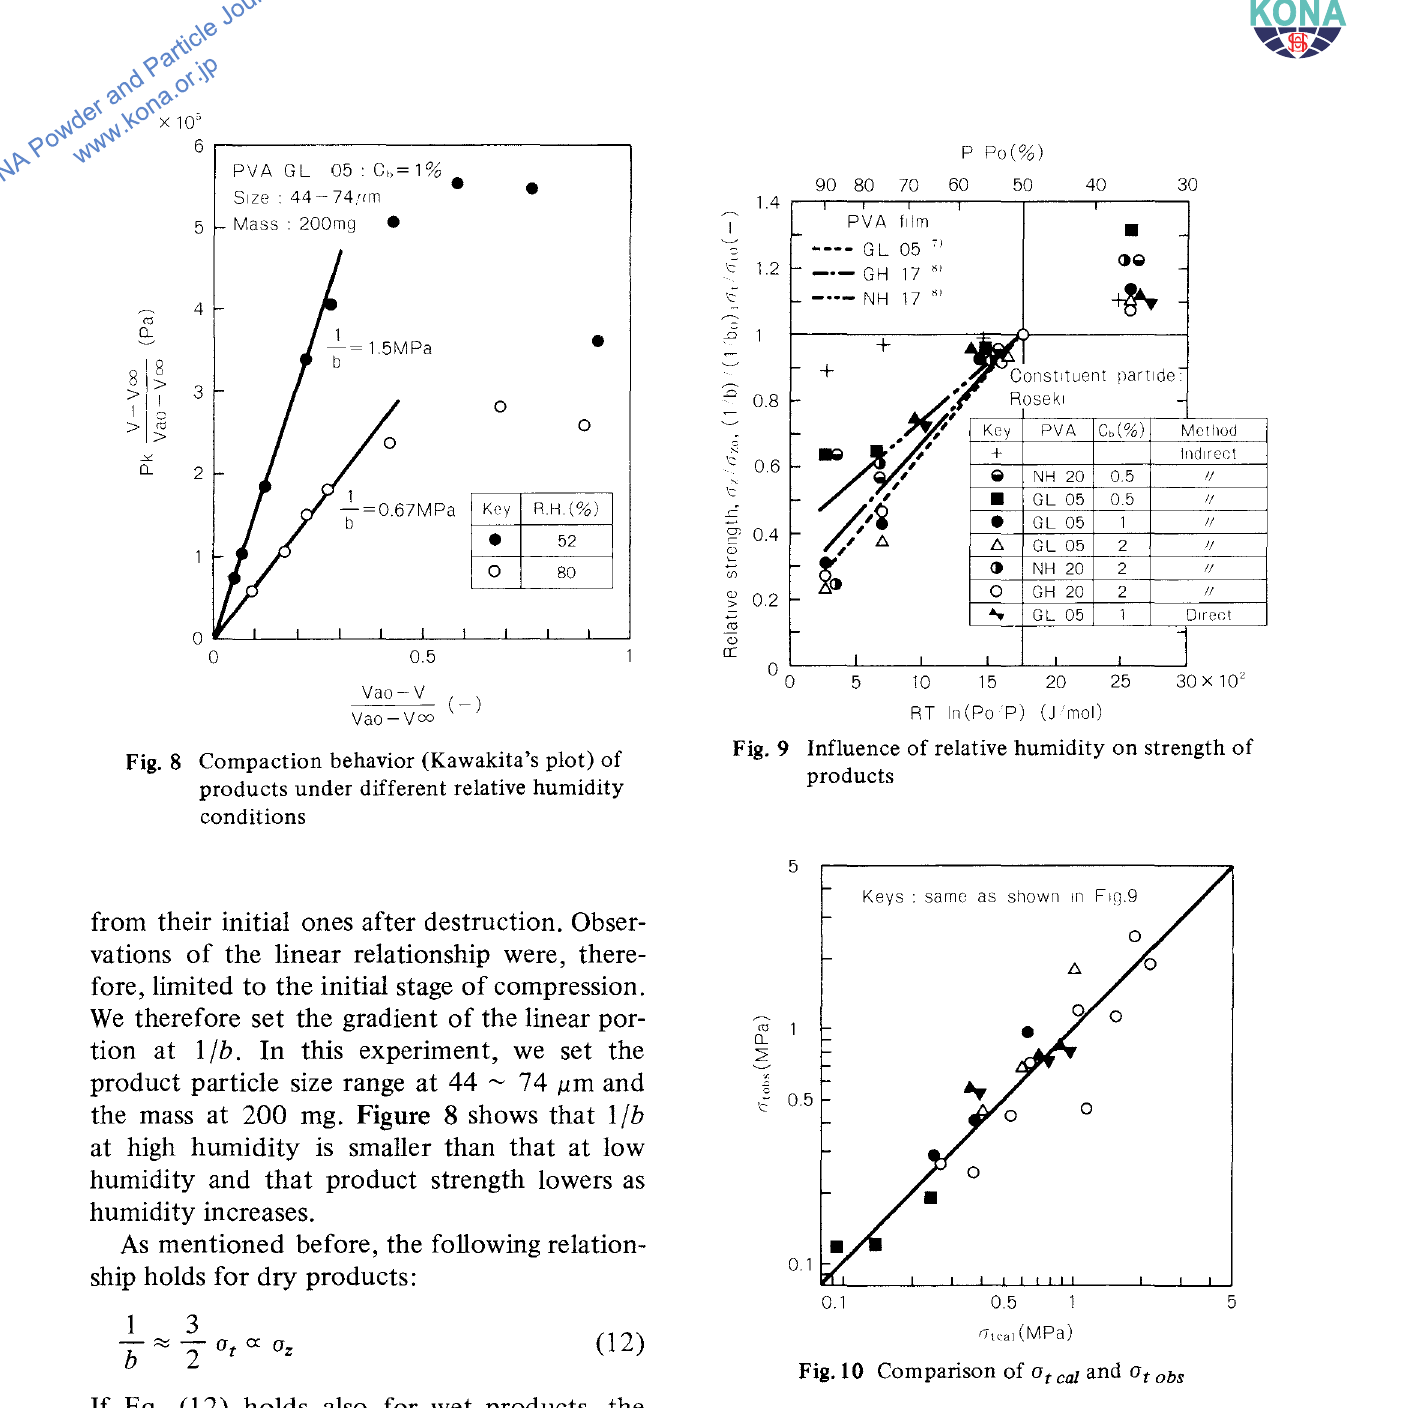
Fig.lO Comparison of at cal and at obs